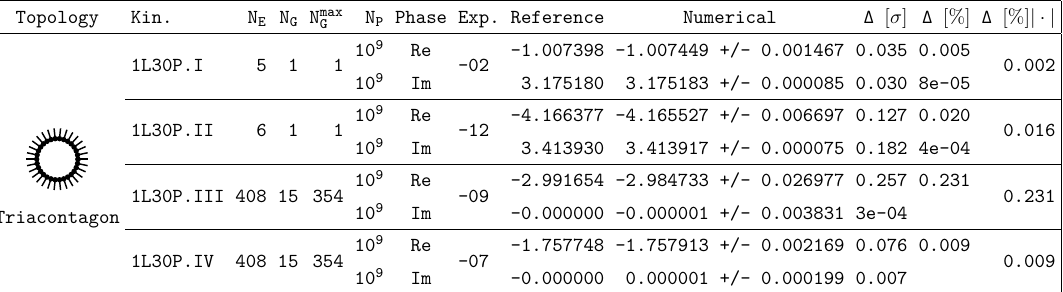
Table 4. Four kinematic configurations of scalar one-loop integrals with thirty external legs. The reference results were calculated with MadLoop [80, 81].